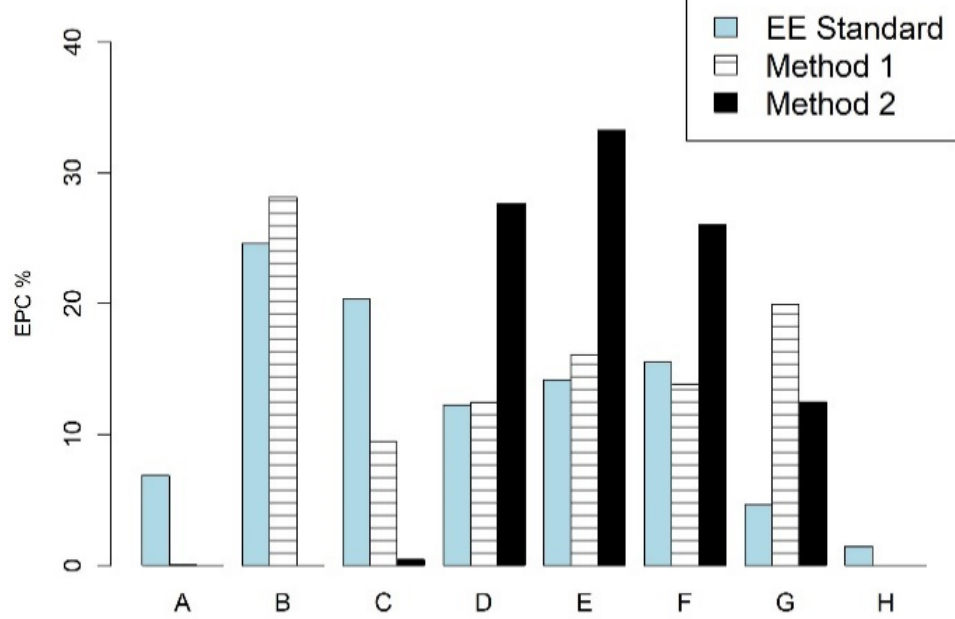
Figure 1. Comparison of number of EPC certificates per class, apartment buildings.